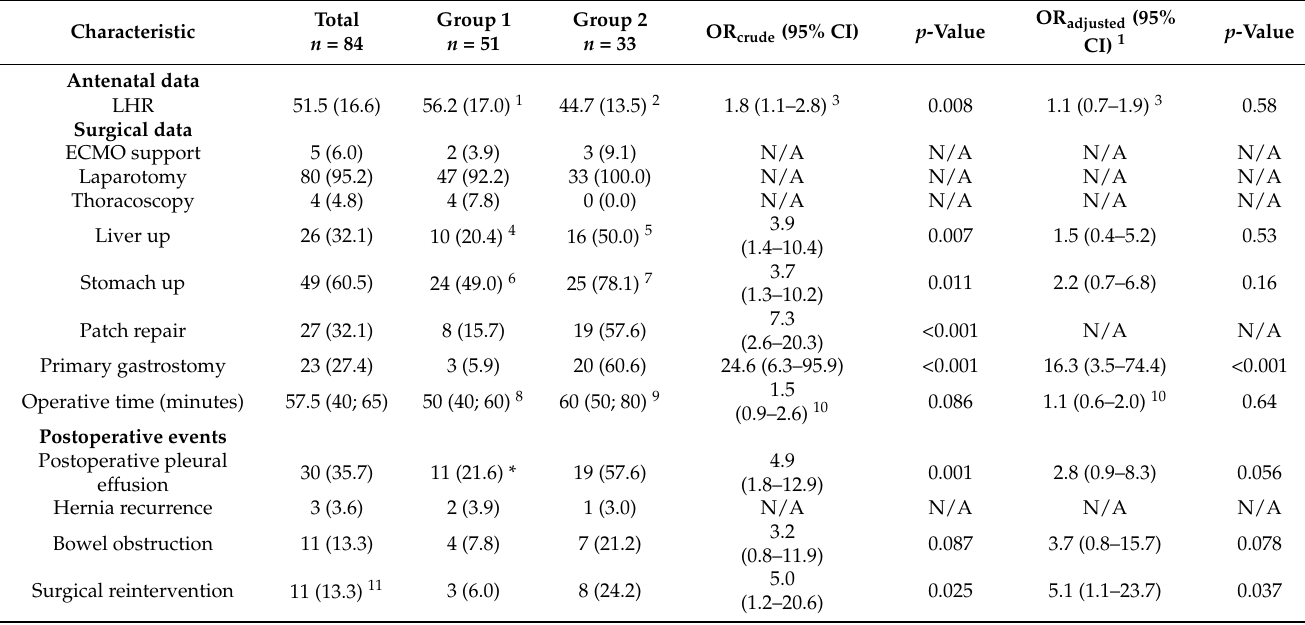
Table 2. Surgical data and postoperative events of the